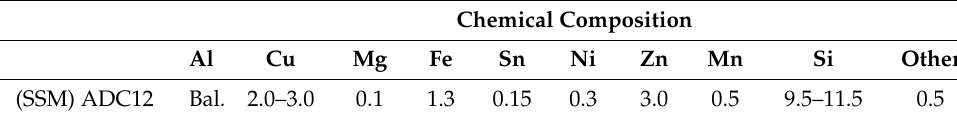
Table 3. Chemical properties of base ADC12.